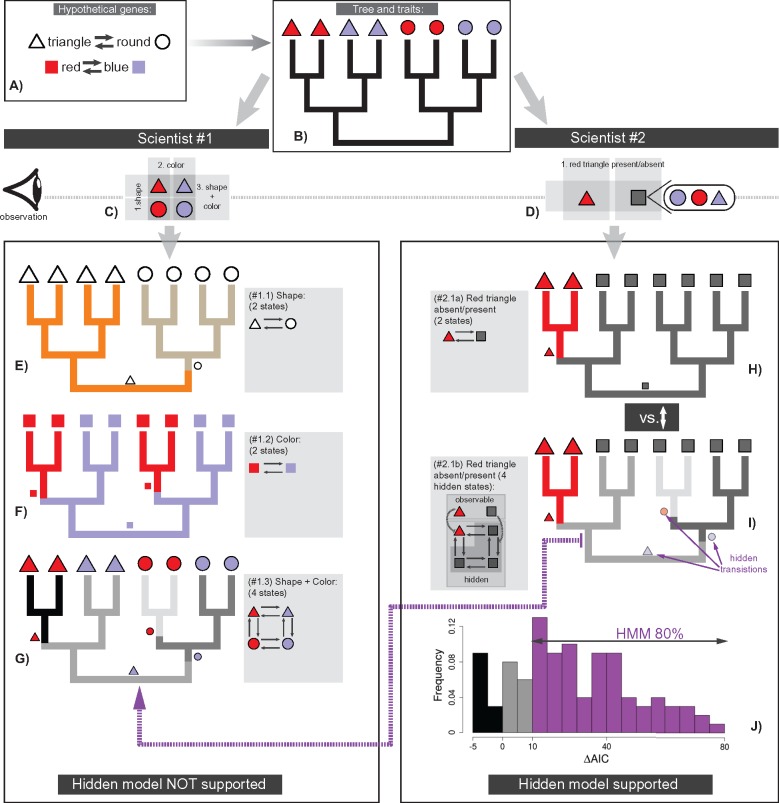
Two-scientist paradox. a) Two independent genes, which produce color and shape traits, evolve on the phylogeny (b). c–g The analyses of the first scientist; neither of the tested models support HMM (only MM models are shown). d–g) The analyses of the second scientist; HMM used in (i) outperforms MM used in (h). The dashed line from (i) to (g) indicates that HMM in (i) approximates MM of (g) j) The distribution of \documentclass[12pt]{minimal}
\usepackage{amsmath}
\usepackage{wasysym}
\usepackage{amsfonts}
\usepackage{amssymb}
\usepackage{amsbsy}
\usepackage{upgreek}
\usepackage{mathrsfs}
\setlength{\oddsidemargin}{-69pt}
\begin{document}
}{}$\Delta $\end{document}AIC values calculated as AIC\documentclass[12pt]{minimal}
\usepackage{amsmath}
\usepackage{wasysym}
\usepackage{amsfonts}
\usepackage{amssymb}
\usepackage{amsbsy}
\usepackage{upgreek}
\usepackage{mathrsfs}
\setlength{\oddsidemargin}{-69pt}
\begin{document}
}{}$_{(MM, from (h))}$\end{document}-AIC\documentclass[12pt]{minimal}
\usepackage{amsmath}
\usepackage{wasysym}
\usepackage{amsfonts}
\usepackage{amssymb}
\usepackage{amsbsy}
\usepackage{upgreek}
\usepackage{mathrsfs}
\setlength{\oddsidemargin}{-69pt}
\begin{document}
}{}$_{(HMM, from (i))}$\end{document}; the color on the histogram marks \documentclass[12pt]{minimal}
\usepackage{amsmath}
\usepackage{wasysym}
\usepackage{amsfonts}
\usepackage{amssymb}
\usepackage{amsbsy}
\usepackage{upgreek}
\usepackage{mathrsfs}
\setlength{\oddsidemargin}{-69pt}
\begin{document}
}{}$\Delta $\end{document}AIC values. The ancestral character state reconstructions in (e–g, h,i) show a possible scenario of state evolution that is provided for the explanatory purpose of the two-scientist paradox.